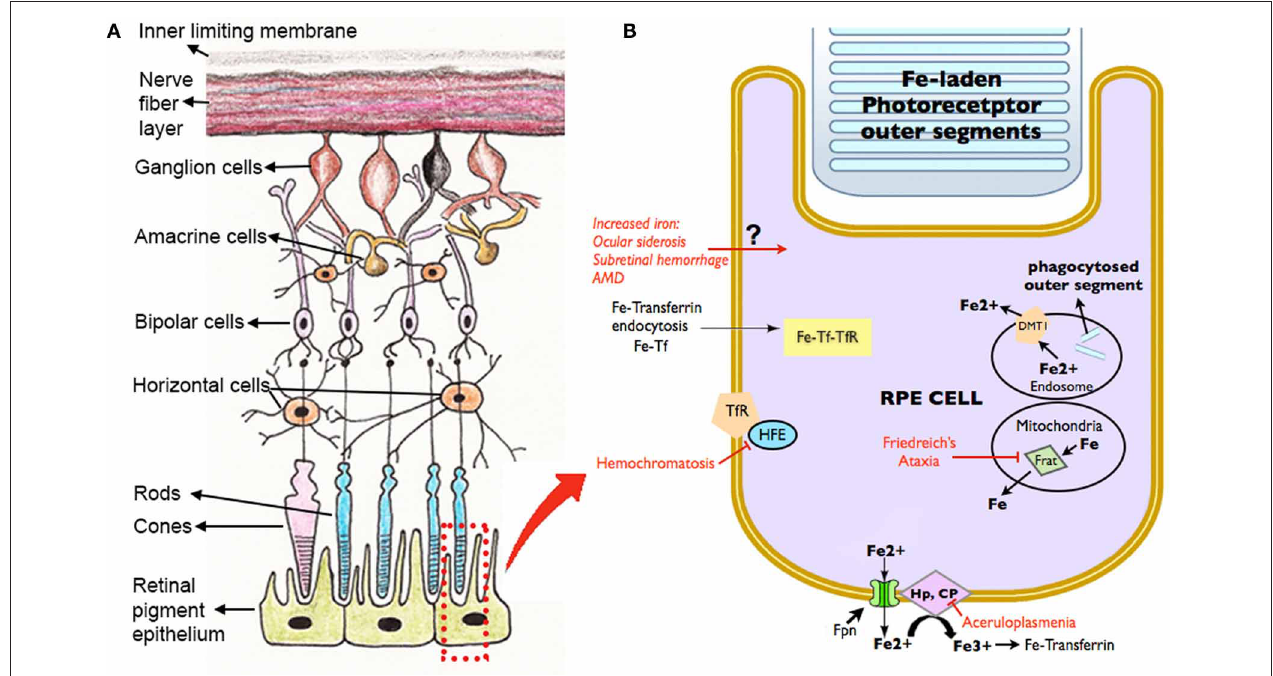
FIGURE 3 | Schematic diagram showing the retinal layers (A), with enlarged view of the RPE and potential routes of iron traffic (B). Several diseases that disrupt retinal iron transport are indicated in red. Proteins involved in iron transport are illustrated: Cp, ceruloplasmin; DMT1, Divalent